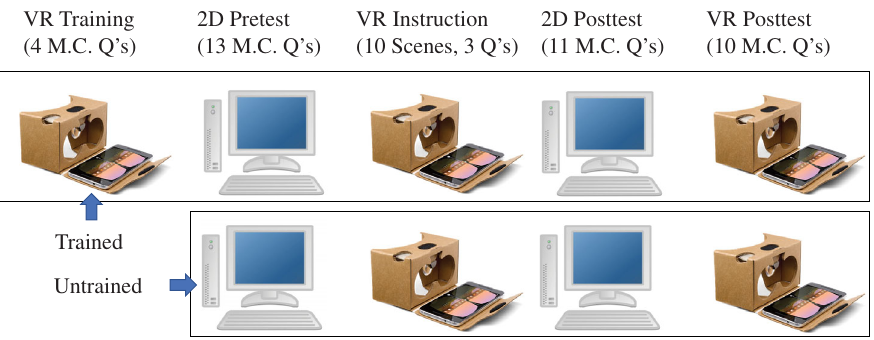
FIG. 2. The sequence of treatment and test questions applied to the two groups: those who received preliminary VR training, and those who did